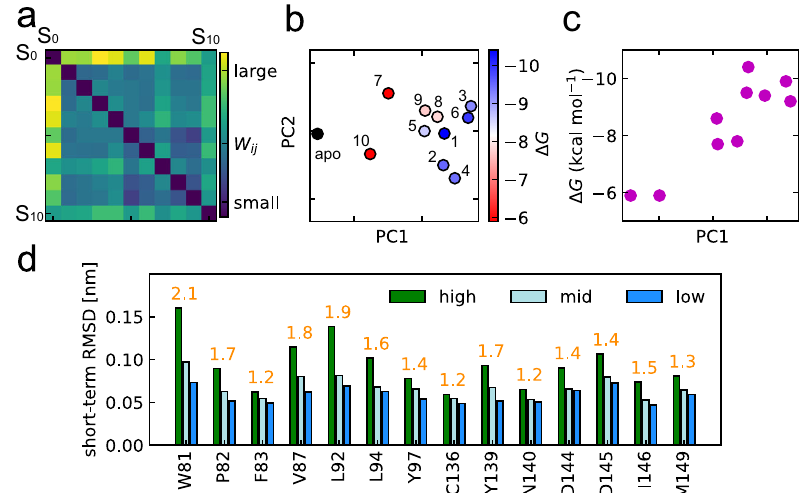
Fig. 3 Differences in the ligand-induced protein dynamics of the BRD4 systems. a Distance matrix of Wasserstein distances between probability distributions of the LDEs from system 0 – 10. Sytem 0 is the apoprotein system and others are labeled according to the ligand. The large Wasserstein distance (yellow) corresponds to a large difference in the protein dynamics. b Embedded points of the distance matrix. The points corresponds to the systems which are colored according to the binding energies and the apoprotein system is in black. The binding energies were obtained from a previous computational research 2 . c Correlation between PC1 and the binding energies. d Characteristic dynamics to the apoprotein system was interpreted for the binding-site residues, in comparison to ligand system 3. The short-term trajectories of the apoprotein system were classi fi ed into apo-characteristic (high), holo-like (low), others (mid) groups, and short-term RMSD d ij was